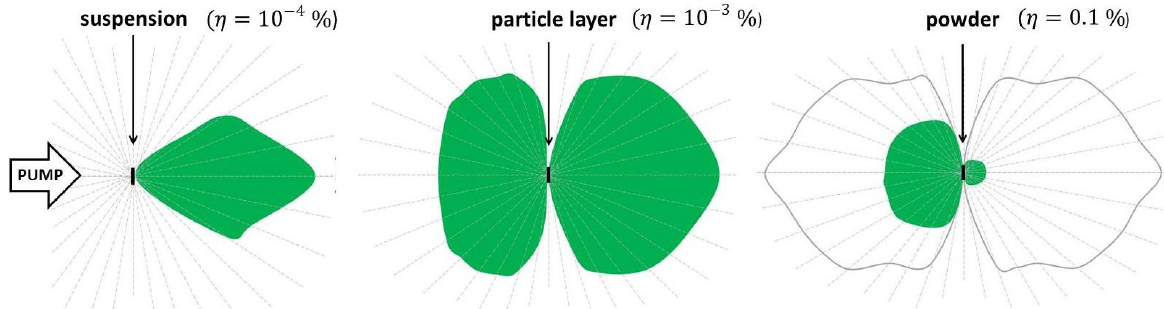
Figure 5. The SHG angular distribution for a liquid suspension, a thin layer of particles on a glass substrate, and a powder at picosecond pumping. For the powder, the angular distribution for the fundamental wavelength is also shown.